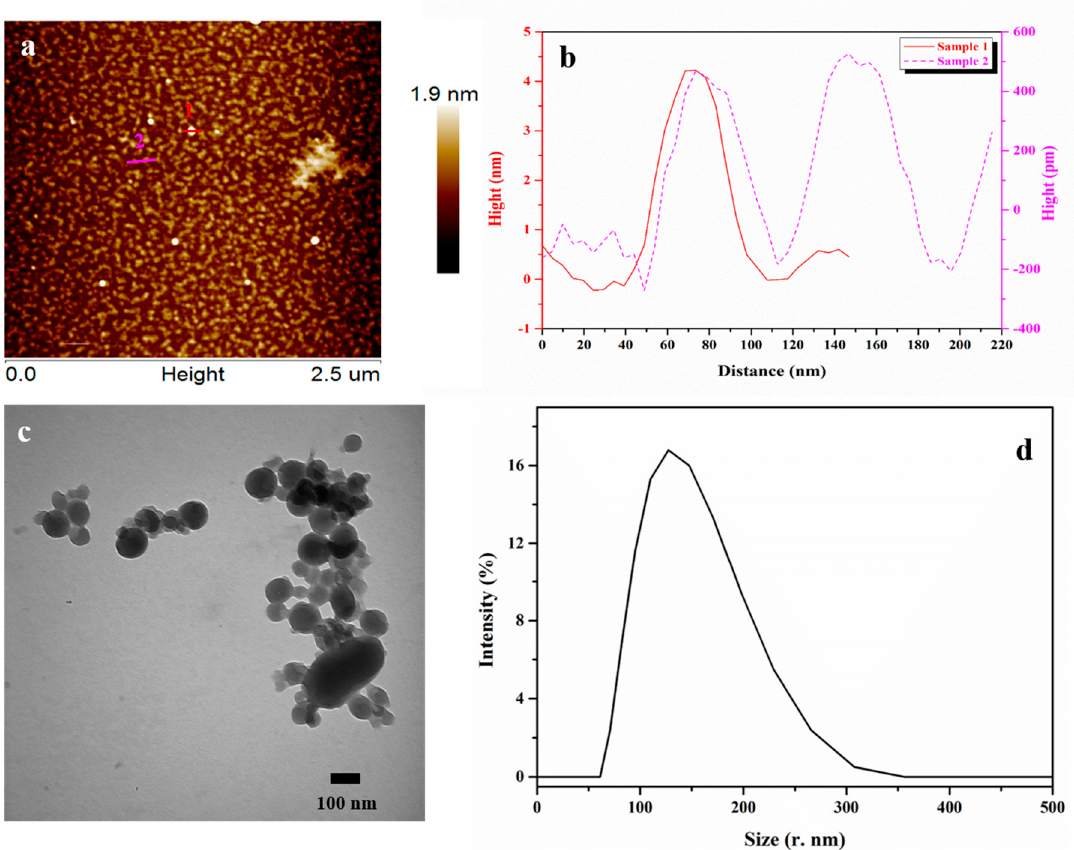
Figure 4. Morphological observation of MIBK-lignin. ( a ) AFM image of MIBK-lignin ( b ) the profiles of samples ( c ) TEM image of MIBK-lignin ( d ) particle diameters distribution analyzed by DLS. (r.: diameter)